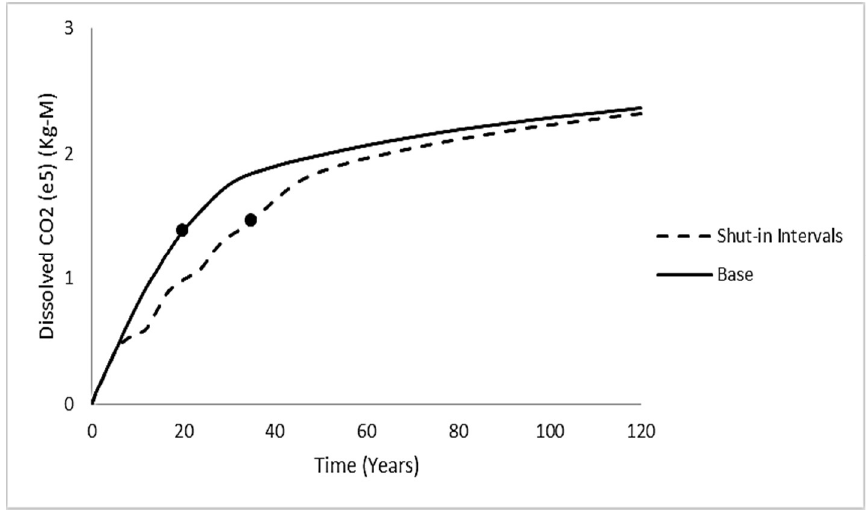
Figure 2. Simulation result for the effect of injection period on CO 2 dissolution in brine vs time.